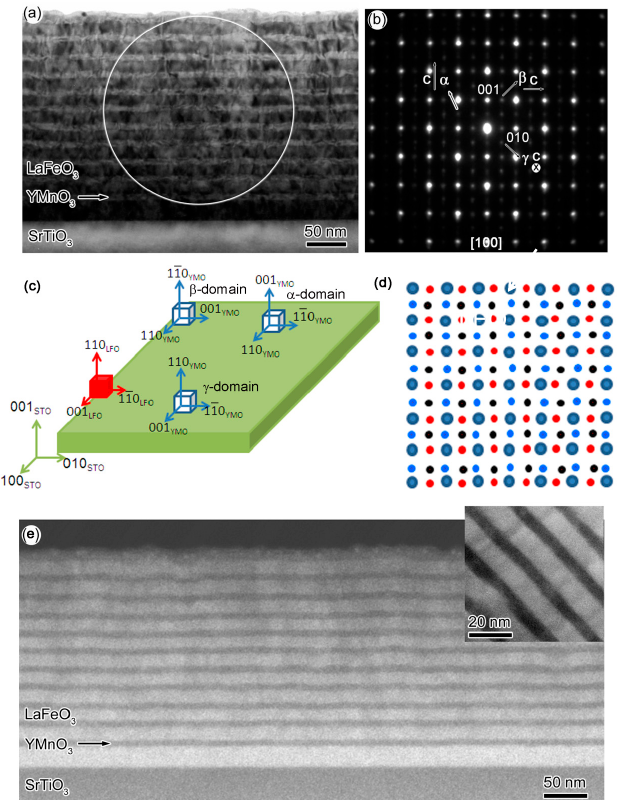
Figure 1. ( a ) The low-magnification transmission electron microscopy (TEM) of LFO-YMO (sample-I) multilayers grown on (001)-SrTiO 3 (STO) substrate; ( b ) The selected-area-electron-diffraction (SAED) pattern of sample-I. The three weak spots coming from multi-domain structure are highlighted by white arrows. The directions of c-axis in three types of domains of YMO are indicated, as well. The SAED pattern of sample-I are the overlap of four electron diffraction patterns: α -, β -, γ -domain of YMO and [001]-zone axis of LFO. The elongation at the high-order reflections is attributed to splitting of corresponding diffractions; ( c ) is the schematic of three type of crystallographic domain between YMO and LFO in α -, β -, and γ -type of domain configurations; ( d ) is the schematic of SAED pattern of α -, β -, and γ -type of domain configurations. Large violet circles represent the basic reflections of the three types of domains. Small blue, red, and black circles represent the weak reflections coming from α -, β -, and γ -type of domain, respectively; ( e ) The low-magnification high-angle-annular-dark-field (HAADF) image of sample-I. The inset is the high-magnification HAADF image.